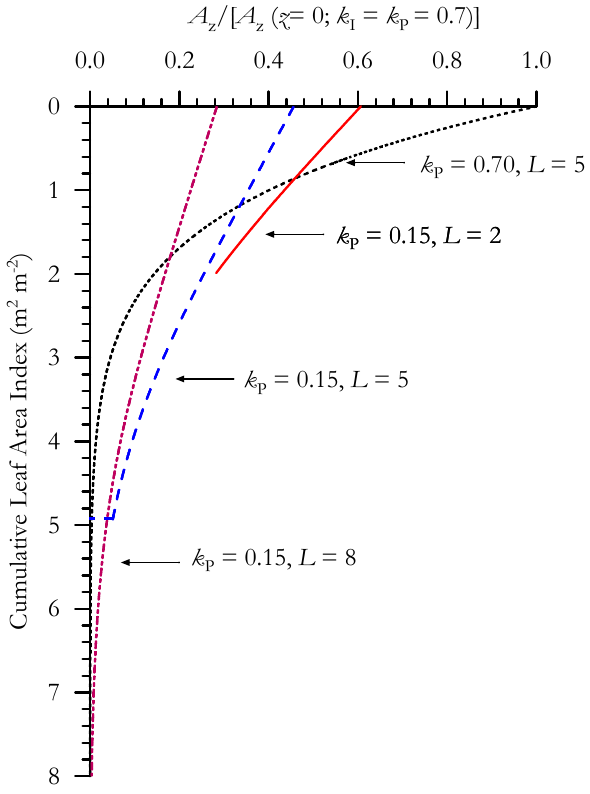
Fig. 2. Variations in the rate of photosynthesis at canopy depth z in the absence of dark respiration, A ∗ z , normalised to that which would occur at the top of the canopy when the extinction coefficient for photosynthetic capacity, k P , is equal to that for light, k I which has in this case been set at 0.7. Values are shown for different combina- tions of k P and leaf area index, L , at an incoming photon irradiance of 2000µmolm − 2 s − 1